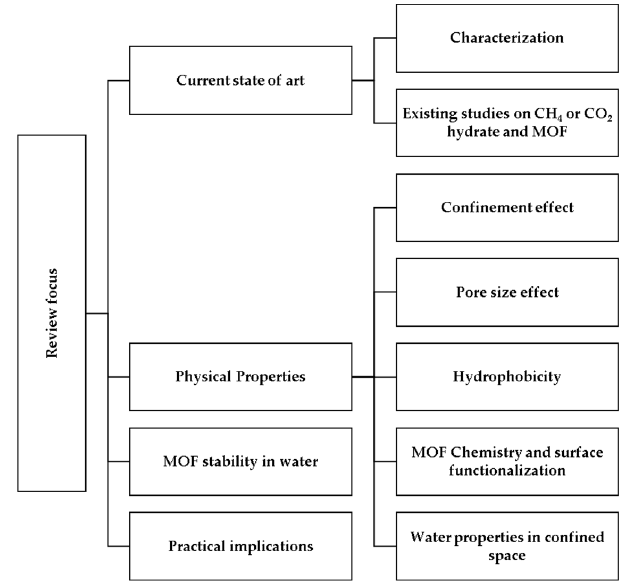
Figure 1. Focus of the current review paper.